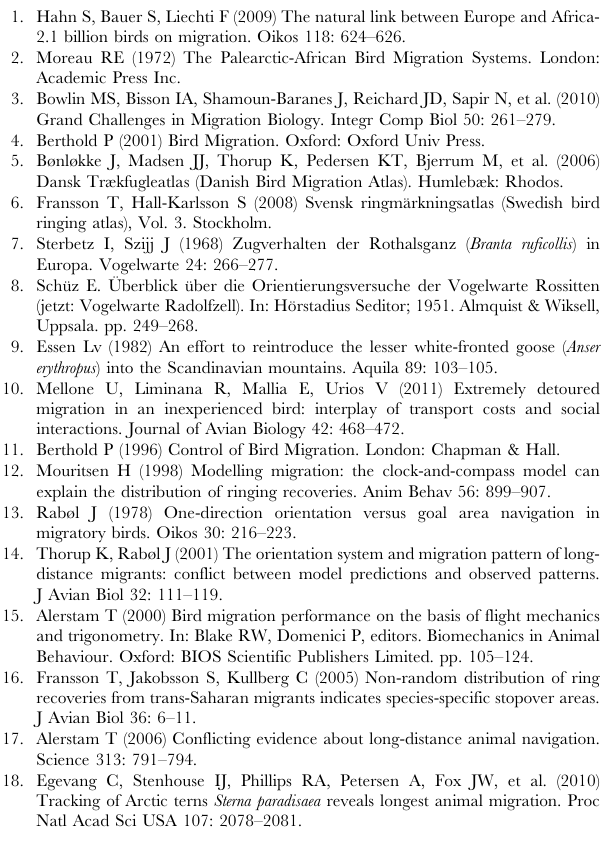
Table S2 Simulating distances between individuals. Simulation results based on vector summation (10,000 bootstraps) of distances between individuals from the four different types of simulation compared with observed data for the cuckoos recorded by satellite tracking. Unshaded rows show the average distances between individuals 6 standard deviation, and shaded rows show p-values for simulated routes to be lower than observed